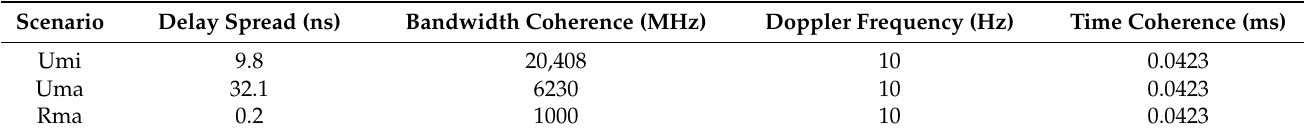
Table 4. Dispersion Parameters of NYUSIM channel.